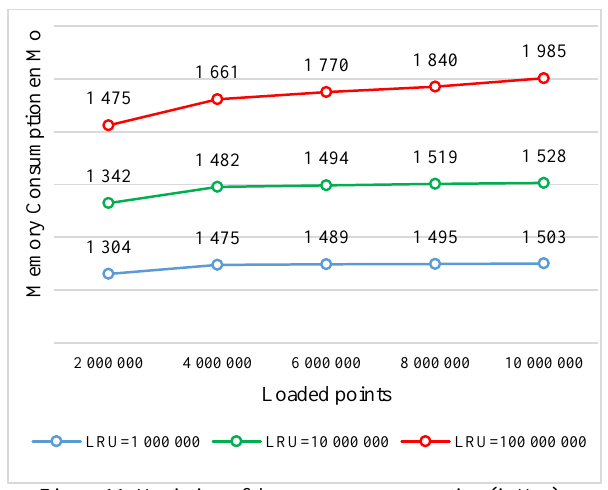
Figure 11. Variation of the memory consumption (in Mo) according to the size of the point cloud loaded and the LRU cache.